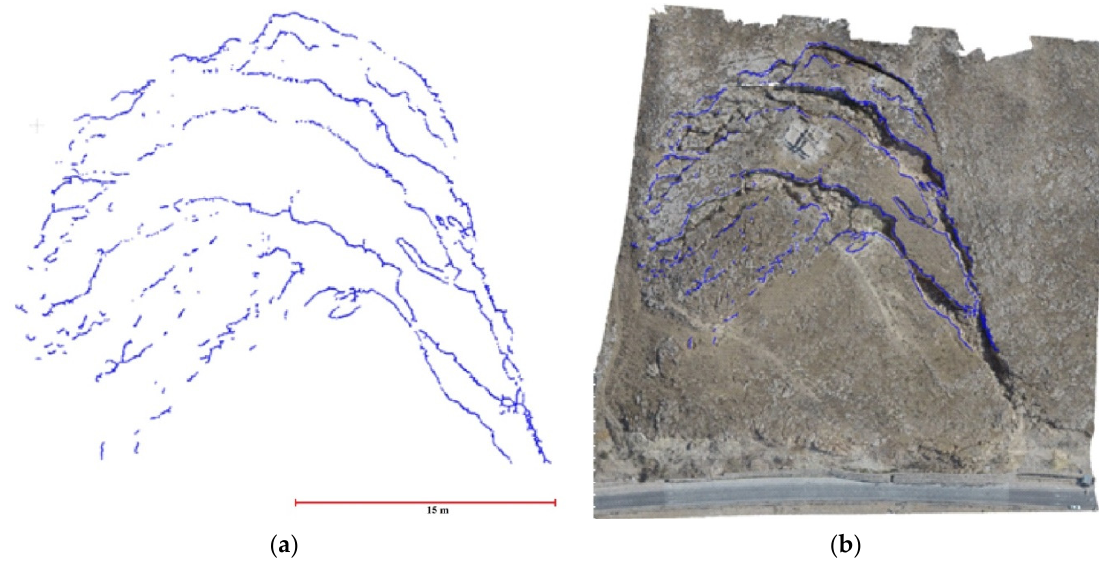
Figure 25. ( a ) Final landslide scarp detection results (blue) based on the topographic surface roughness index and ( b ) the scarps overlaid on the orthophoto using UAV images of the study area.